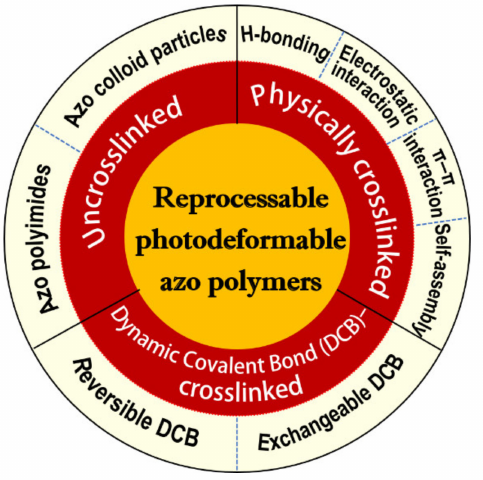
Figure 1. Schematic illustration for the outline of this review